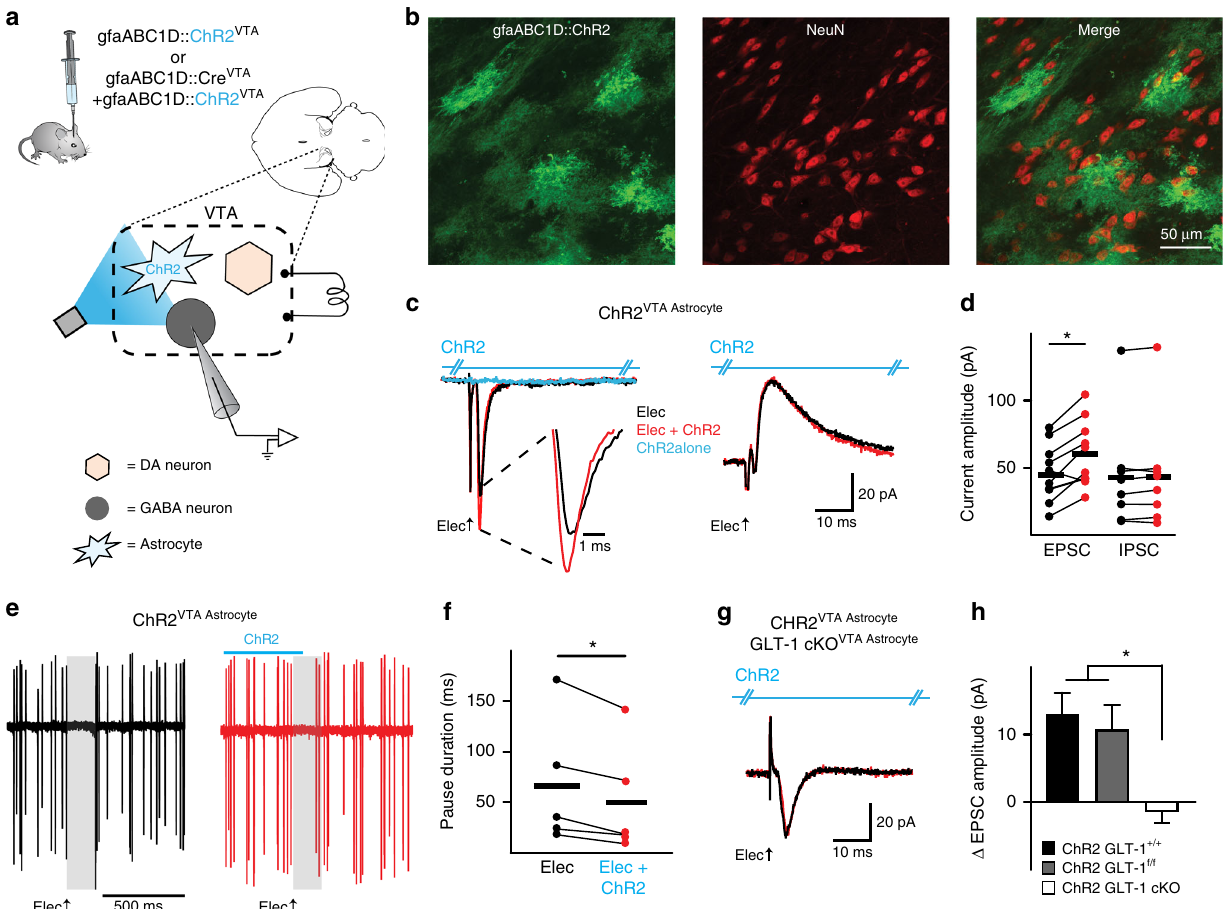
Fig. 2 Astrocytic GLT-1 increases the excitation of VTA GABA neurons. a Schematic showing the microcircuitry of the VTA and manipulations performed. b Immunocytochemistry images (×20 objective) showing lack of co-localization between ChR2 (green, note characteristic astrocyte morphology) and NeuN (red) within VTA. c Example voltage-clamp recordings (left V h = − 55 mV, right V h = + 10 mV). The inward current (left), but not the outward current (right), increases when astrocytes are photoactivated (ChR2, blue hash marked horizontal line above traces) concurrently with electrical stimulation (Elec.) of neuronal afferents (red traces) in a GLT-1 + / + mouse. ChR2 photoactivation alone produces no response (blue trace; see Supplementary Fig. 8). d Summarized data from VTA GABA neurons where ChR2 stimulation on VTA astrocytes increases peak EPSC amplitude (GLT-1 + / + , paired t-test t = 4.457, P = 0.016, n = 10 cells) without altering IPSCs (paired t -test t = 1.318, P = 0.22, n = 8 cells, 4 mice). e Five overlaid traces (9) (7) of a cell-attached recording from a VTA GABA neuron. Electrical stimulation of neuronal afferents in the VTA (black traces) elicits a pause in fi ring activity (gray area). However, when ChR2 on VTA astrocytes (gfaABC1D::ChR2 VTA ) is photoactivated concurrently with electrical stimulation (red traces) the pause duration is decreased (see spikes within the gray area, which is pause duration of electrical stimulation alone). f Summarized data from GABA neurons demonstrating a decrease in pause duration (paired t -test t (4) = 3.345, P = 0.028, n = 5 cells, 2 mice) elicited by ChR2 stimulation on